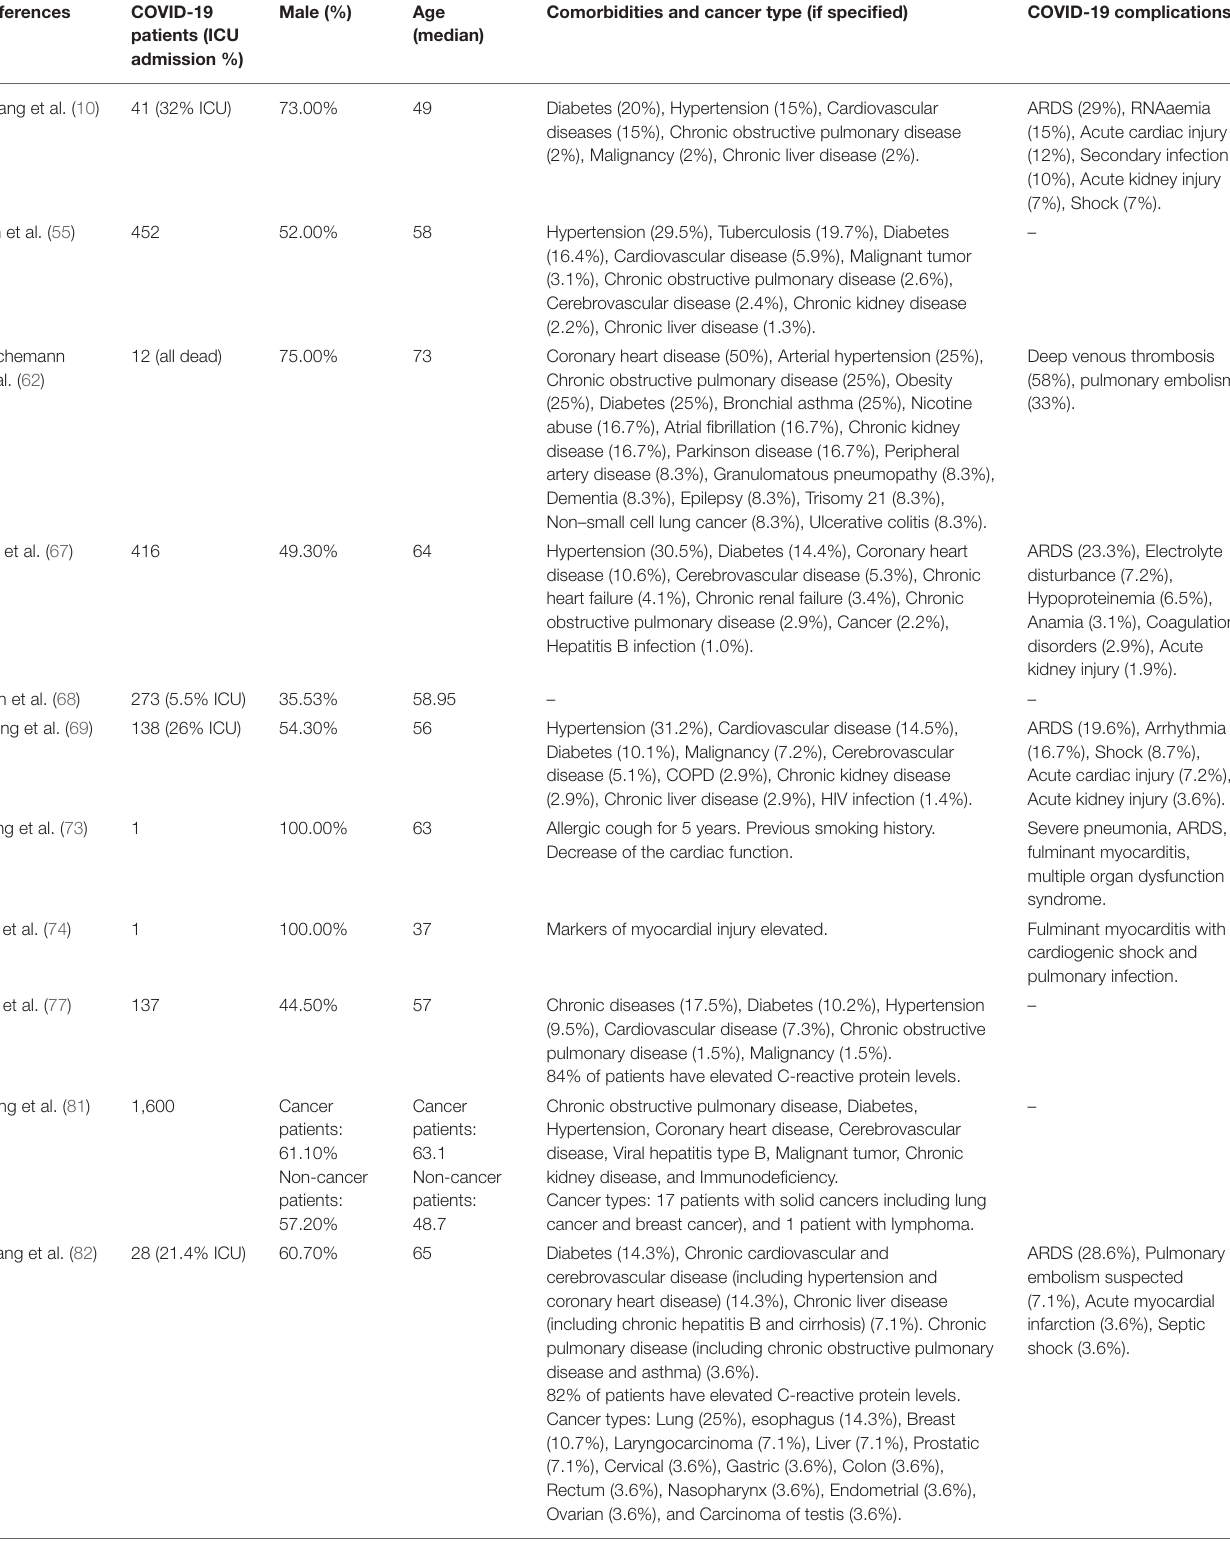
TABLE 1 | Comorbidities and complications in COVID-19 patients suffering from cardiac injury identified in the studies included in this